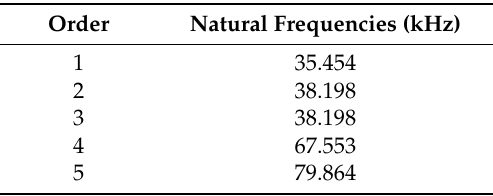
Table 1. Natural frequencies of the ultrasonic horn.